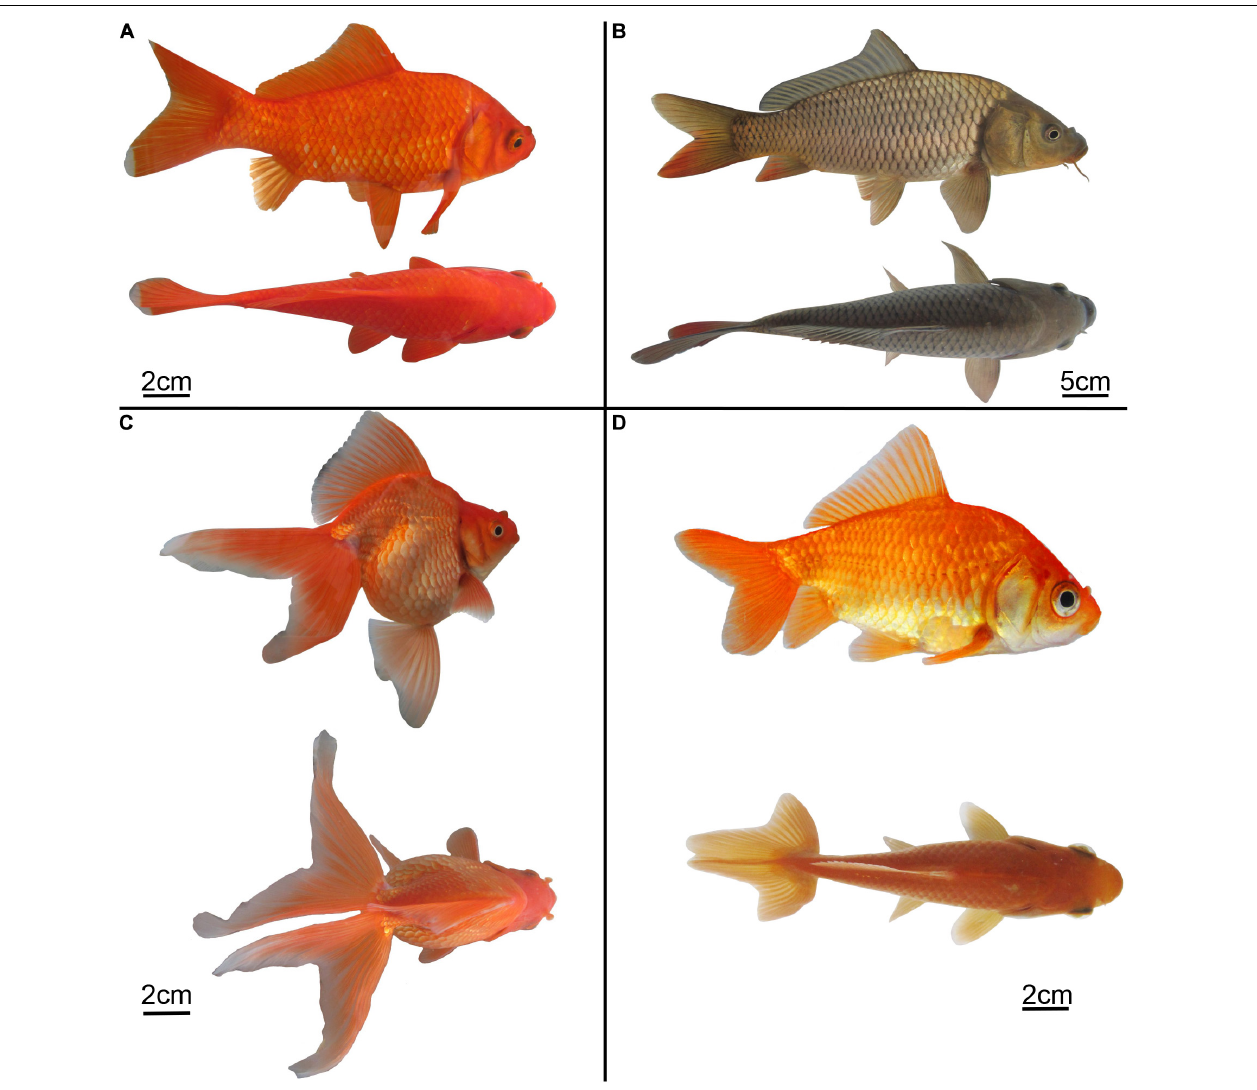
FIGURE 1 | Lateral and dorsal views of phenotypically-representative examples of the four fish taxa included in this study. (A) Red crucian carp (RCC, Carassius auratus ). (B) Common carp (CC, Cyprinus carpio ). (C) Natural/wild-type goldfish (NG, Carassius auratus ). (D) Experimental hybrid goldfish (EG). Scale bars, 2 cm (A,C,D) , 5 cm (B)